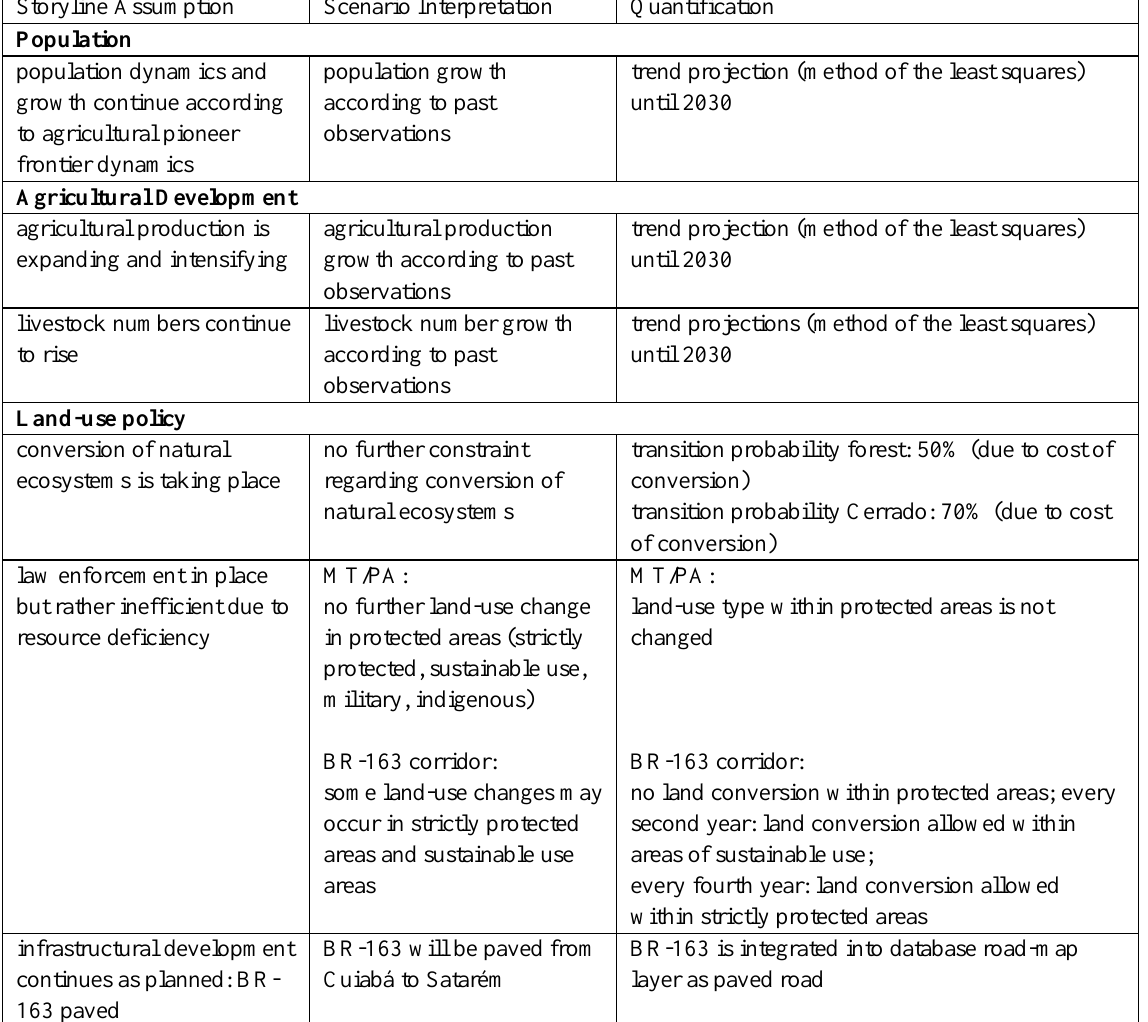
Table A1.1. Translation of story line statements to model drivers (Trend